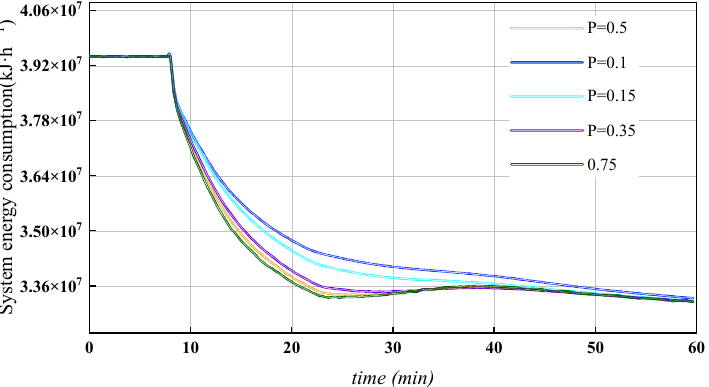
Figure 11. Comparison of different TIC-125 PID parameters’ energy consumption curves. Dynamic model simulations indicated that the maximum P value of TIC-125 should not exceed 0.8; otherwise, stable control could not be achieved. Therefore, five different P values within the 0.1–0.75 range were selected for simulation, the result is shown in Figure 11. Simulation results were reacted, and the parameter, P, of TIC-125 was reduced, which facilitated smoother control of the process’s energy consumption fluctuation. It did not improve the energy consumption level.